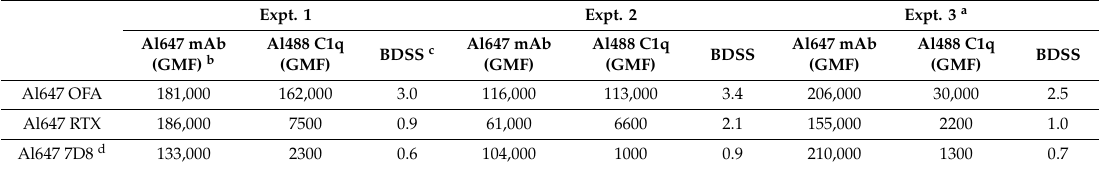
Table 2. Binding of Al488-labeled C1q to mAb-opsonized Daudi cells and colocalization of C1q with